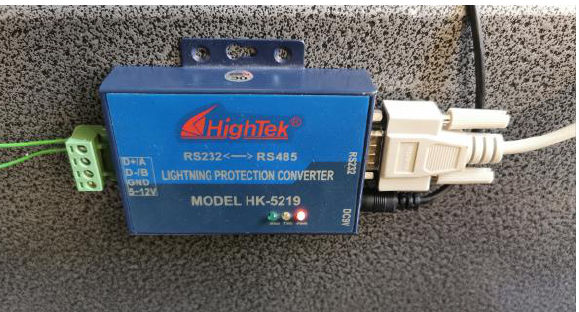
Figure 6. Connection of WattNode to the server via an RS232-to-RS485